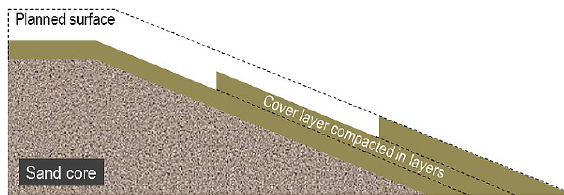
Fig. 5. Standard way of installing a cover layer on a sand dike core in layers of 20–50 cm